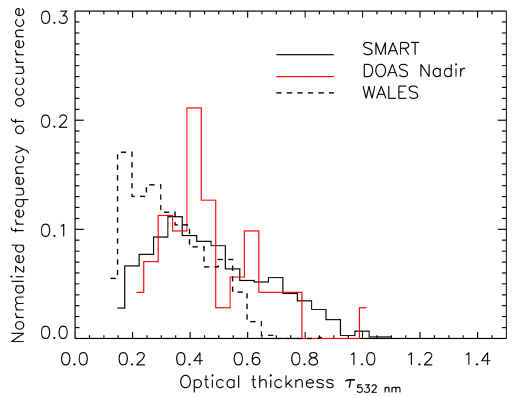
Figure 16. PDFs of cirrus optical thickness τ at λ = 532nm re- trieved from SMART, mini-DOAS and WALES measurements. The bin size is 0.05 units of τ